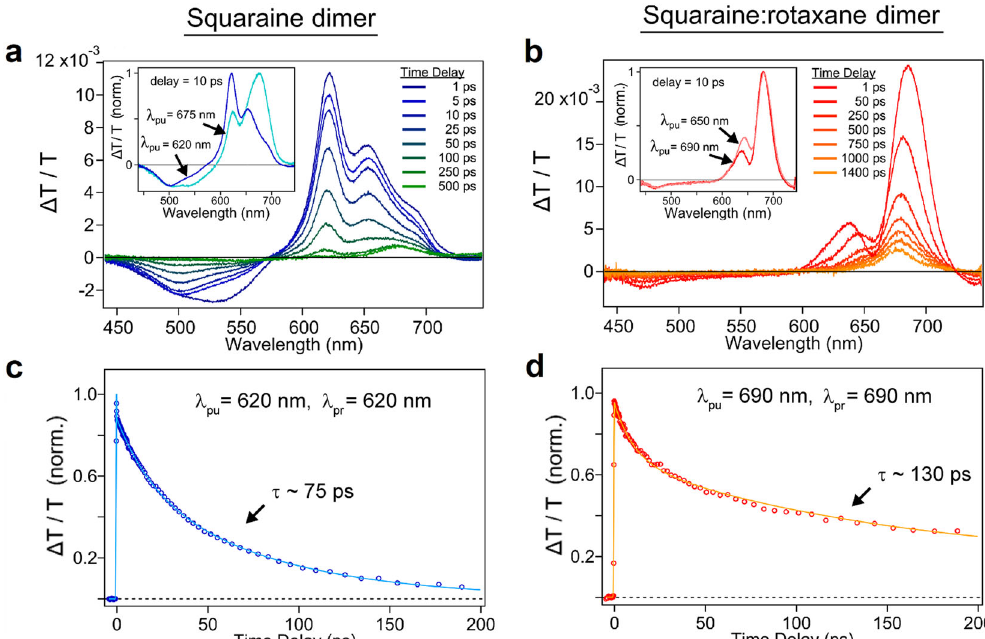
Fig. 5 Transient absorption of SQ and SR dyes templated in the form of transverse dimers using a DNA Holliday junction. a , b Selected TA spectra of the SQ and SR dimer solutions. Experiments were performed with incident pump wavelengths of 620 and 690 nm, respectively. The inset in each panel displays 10 ps spectra obtained for the solutions at two distinct pump wavelengths with comparable pump fl uence. c , d Selected kinetics trace for the SQ and SR dimer solutions obtained with pump wavelengths of 620 and 690 nm, respectively. The probe wavelengths were selected to coincide with the largest amplitude GSB feature appearing in the TA spectra of each solution at ca. 620 and 690 nm, respectively. The kinetics traces have been normalized to their maximum amplitude. A fi t from a global target analysis (see Supplementary Note 15) overlays the data in each panel and the lifetime of the corresponding dimer structure is indicated in the